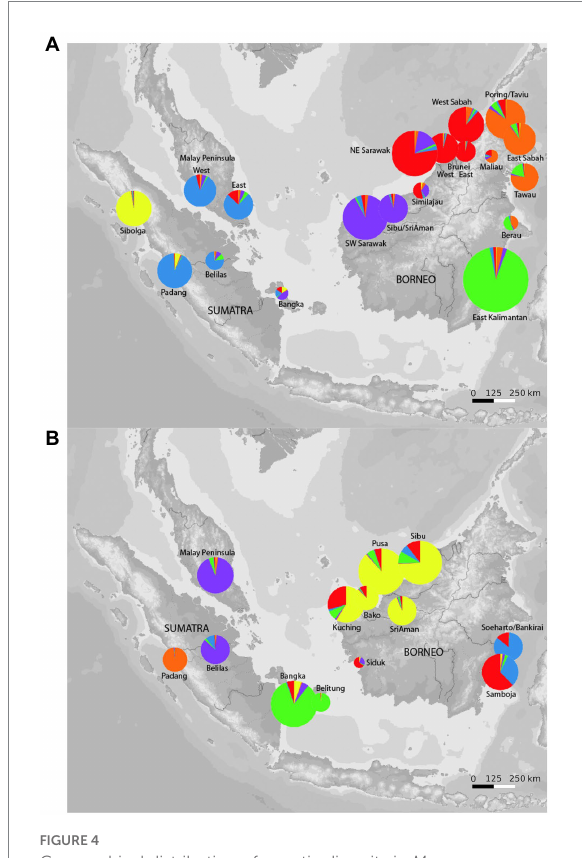
FIGURE 4 Geographical distribution of genetic diversity in Macaranga gigantea (A) , geographical distribution of genetic diversity in Macaranga pruinosa (B) . Pie charts show the relative proportion of ancestry in each of six genetic clusters based on ncSSR data and defined by a Bayesian cluster analysis using STRUCTURE 2.3.4. Circle sizes are proportional to sample